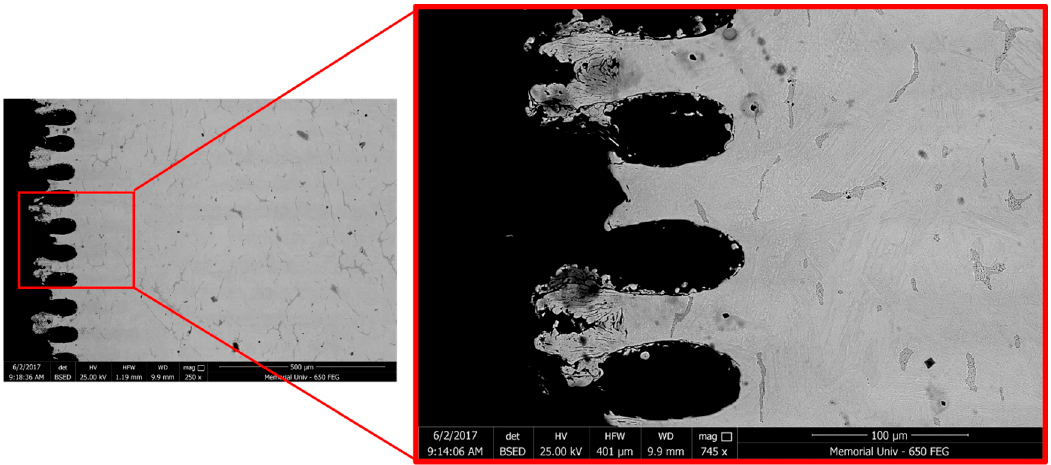
Figure 6. Surface features of the sample with varied channeled morphology.